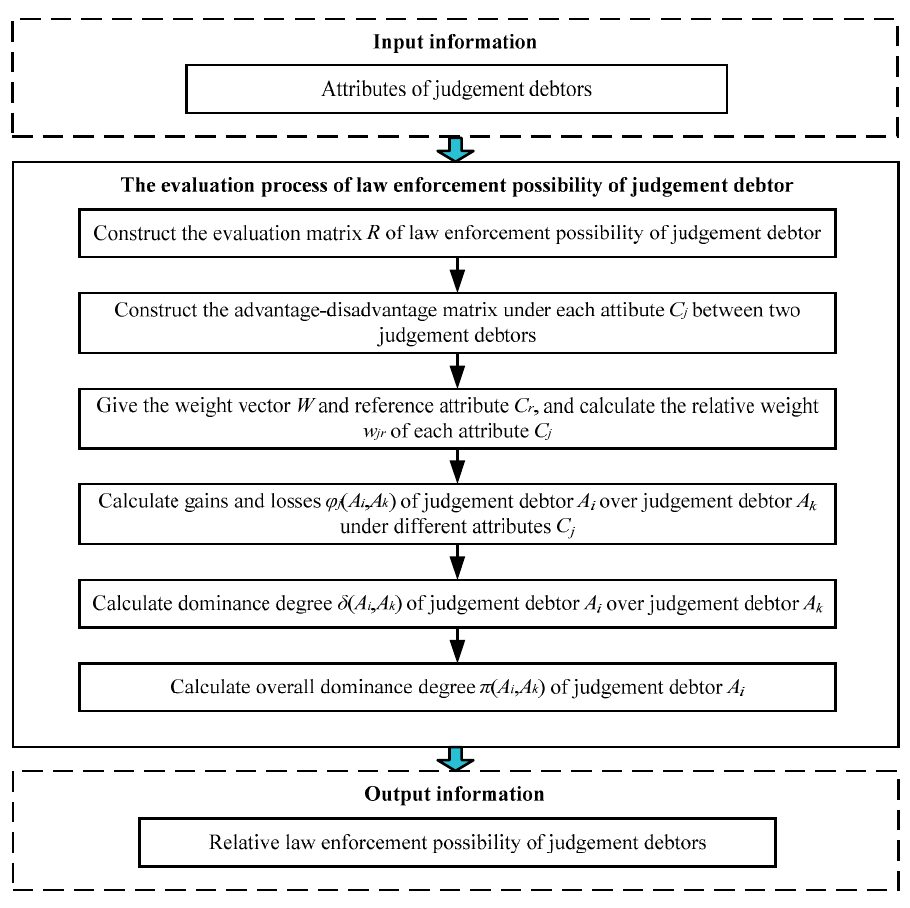
Figure 1. Flow chart of law enforcement possibility evaluation of judgment debtors based on the hybrid TODIM method.